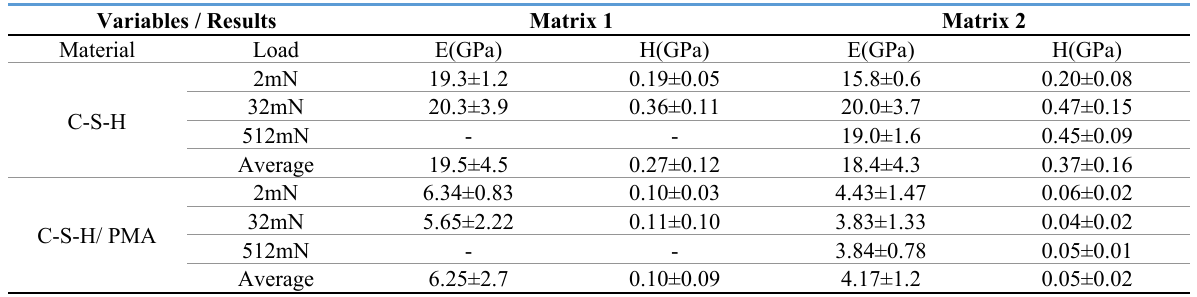
Table 4. Elastic modulus and hardness of C-S-H and C-S-H/PMA for different loads.